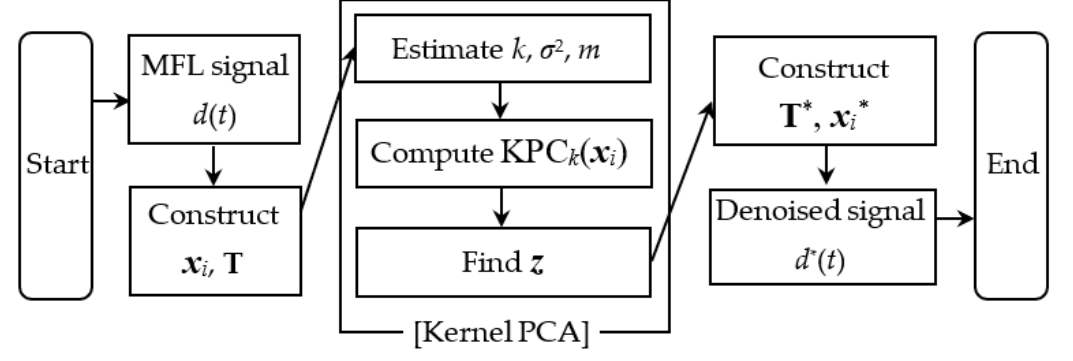
Figure 3. A corrosion detection process proposed in this study.